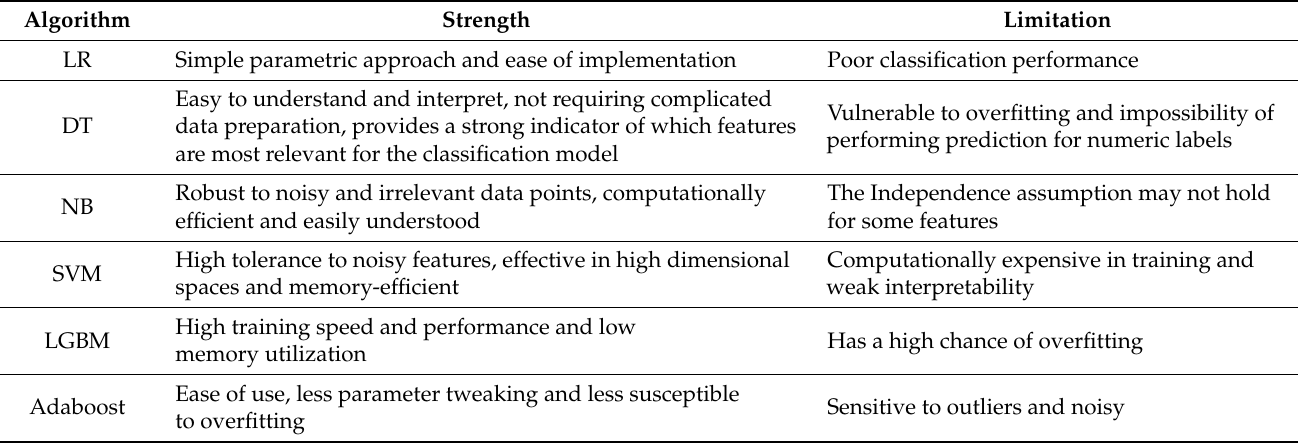
Table 2. Comparison between different algorithms’ strengths and limitations.